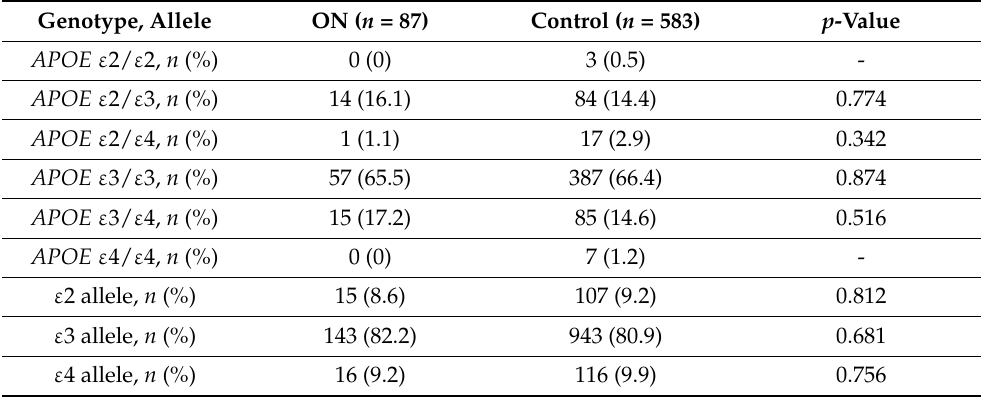
Table 2. APOE genotype and allele frequencies in patients with ON and control groups.